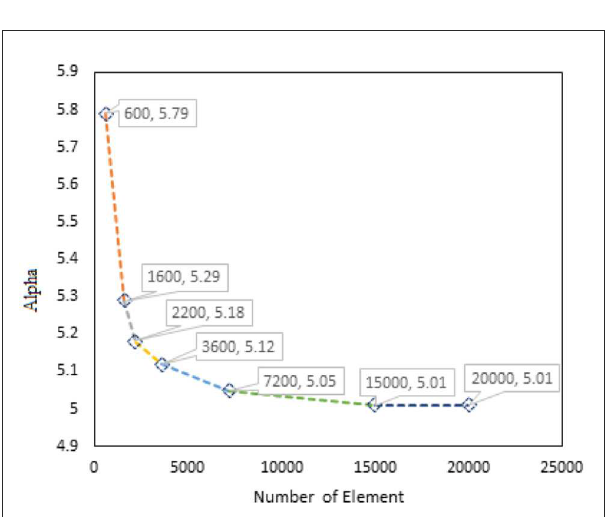
FIGURE5 Graph of α vs. number of elements for PVA-C modeled with 15% concentration and finite thickness.